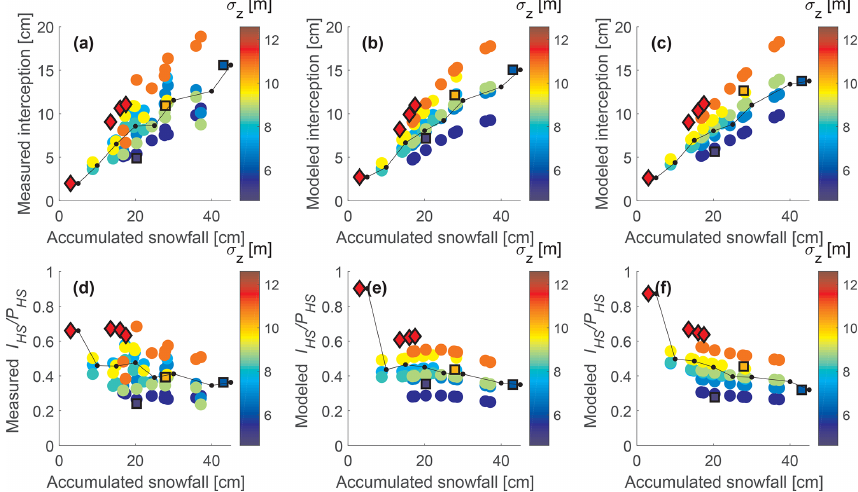
Figure 5. Snow depth interception I HS (a, b, c) and interception efficiency I HS /P HS (d, e, f) as a function of accumulated open-site snowstorm precipitation P HS and standard deviation of the lidar DSM σ z (in color). The y axis of the first column shows measured data, the second column shows model output with Eq. (2), and the third model output with Eq. (3). Site means for each storm event are depicted with colored circles for the development data set from Switzerland, and symbols with a black border depict the validation data sets, with squares for data from the US and diamonds for data from France. Storm means (in P HS bins) are shown in black.